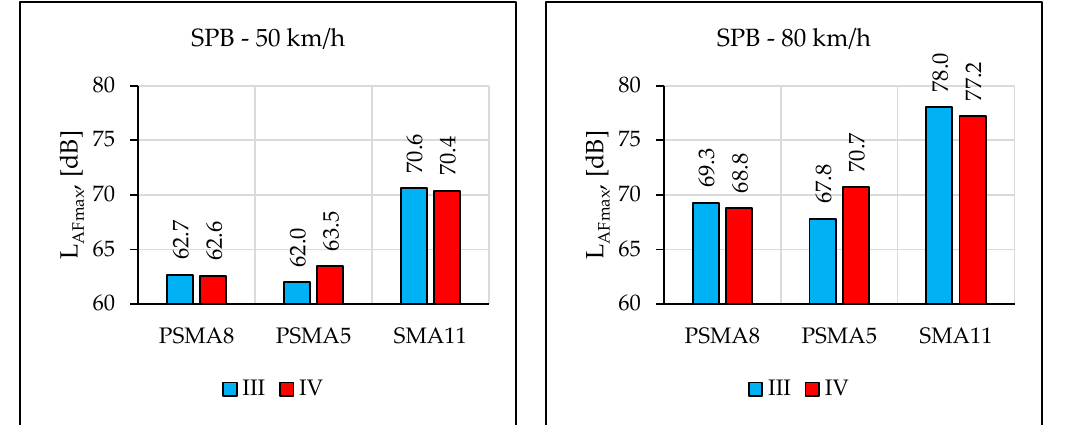
Figure 29. Comparison of the maximum sound levels according to the SPB method obtained in two measurement sessions.